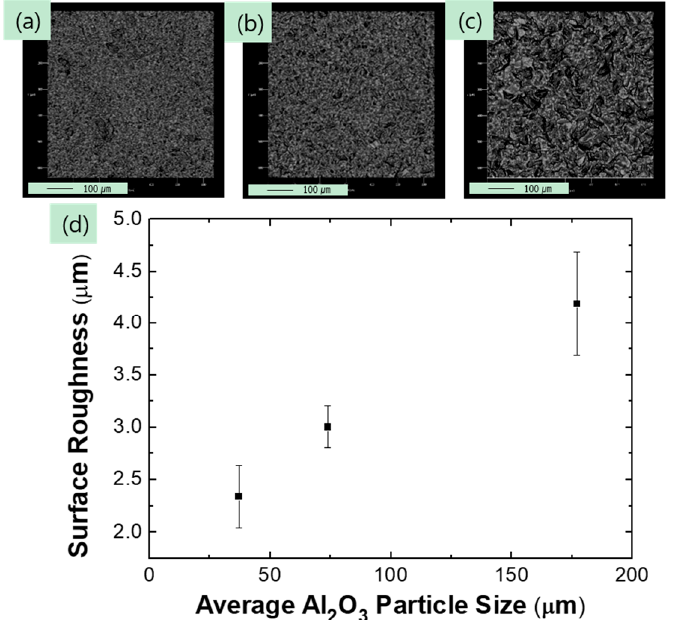
Figure 2. Laser scanning confocal microscopy images on the surfaces of thermoelectric element blocks after ( a ) #400 Al 2 O 3 powder sanding (37 µm); ( b ) #200 Al 2 O 3 powder sanding (74 µm); and ( c ) #80 Al 2 O 3 powder sanding (177 µm). ( d ) Surface roughness as a function of alumina powder particle size.